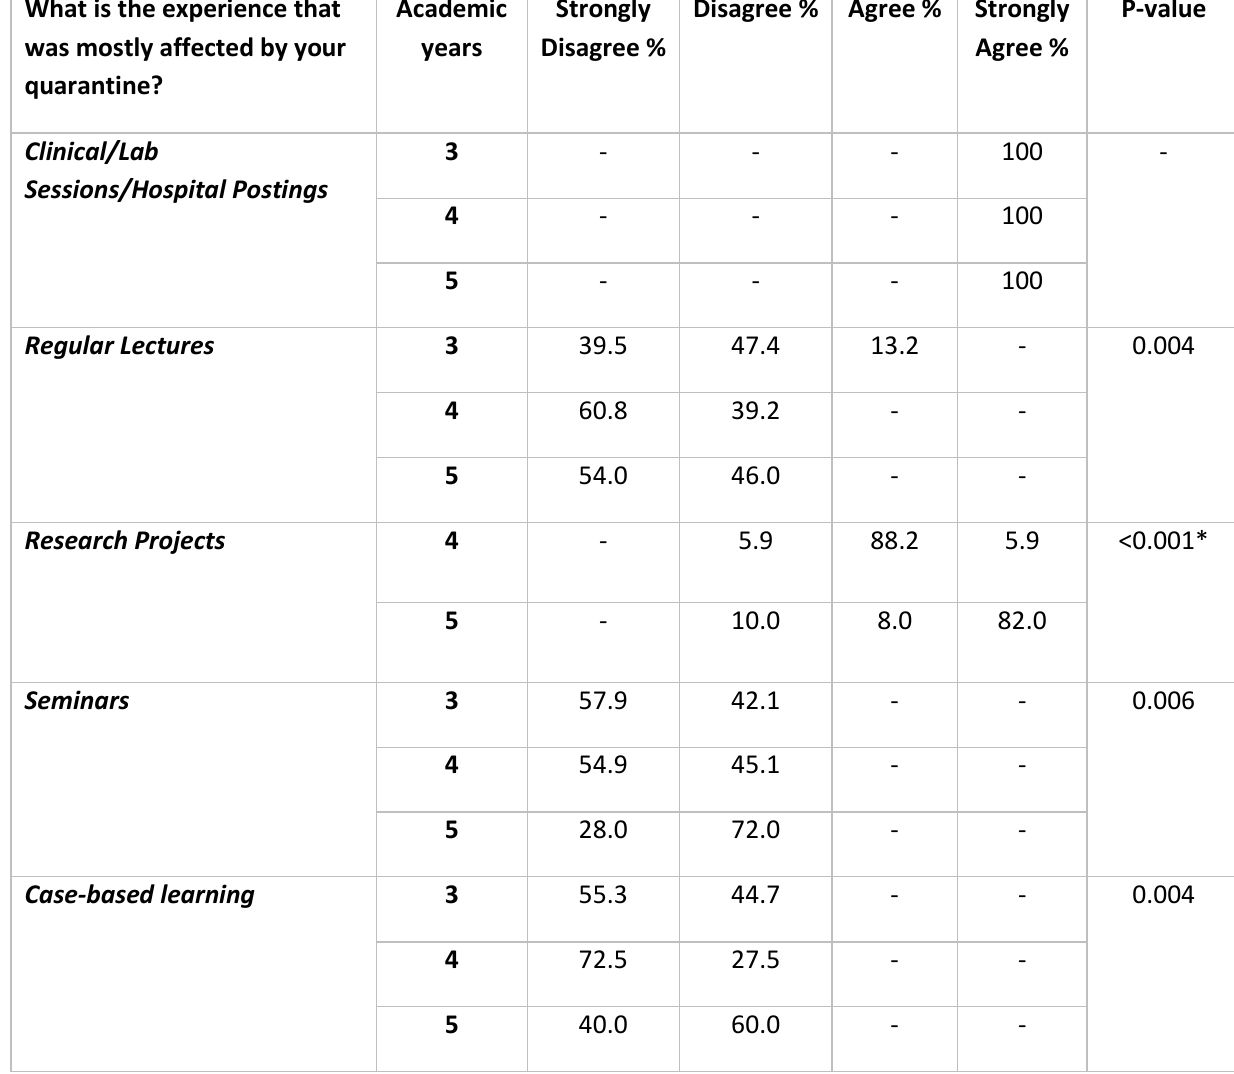
Table 3: Experiences mostly affected by quarantine among year 3,4 and 5 dental students What is the experience that was mostly affected by your